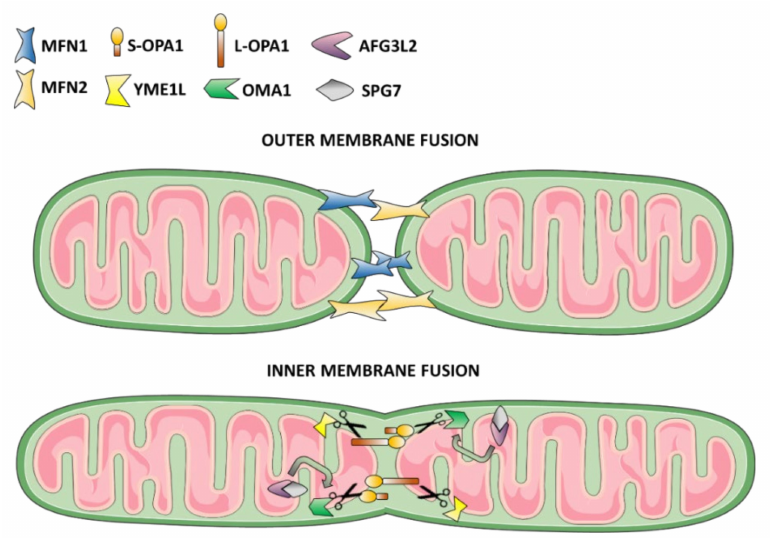
Figure 2. Proteins regulating mitochondrial fusion and associated with optic atrophy. A graphical representation of outer and inner membrane fusion with emphasis on proteins involved in the degeneration of optic nerve (see also Table